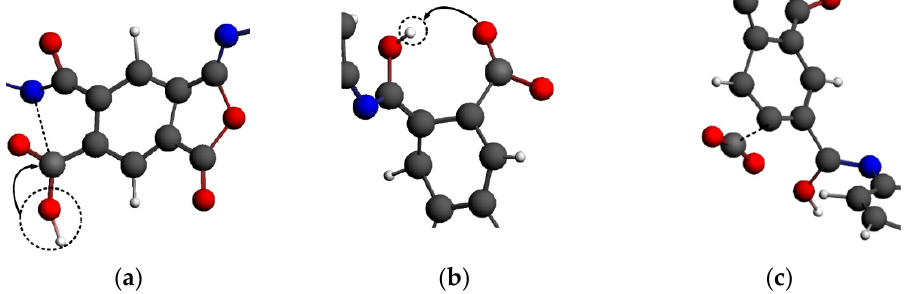
Figure 20. Adsorption process and mechanism of ∙ OH. ( a ) The addition reaction of hydroxyl; ( b ) The transfer of hydrogen; ( c ) The exfoliation of CO 2 molecules from main chain.